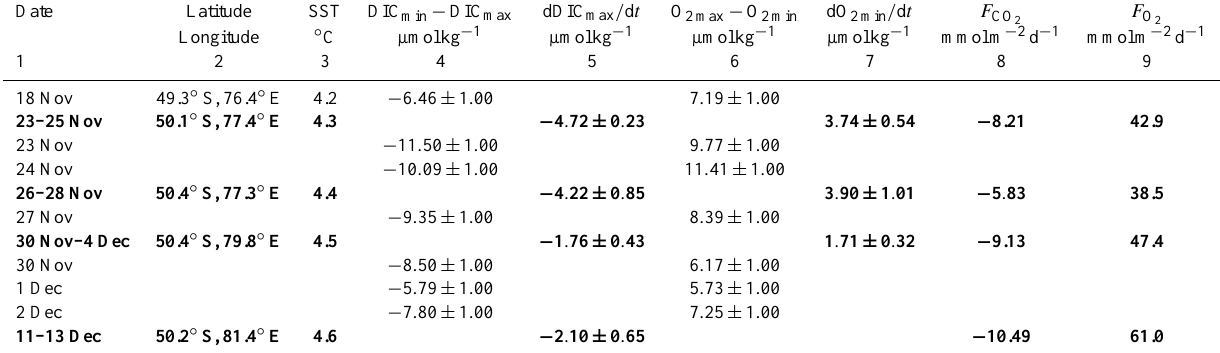
Table 1. Difference between the extrema of DIC and O 2 measured in the warm surface layer (columns 4 and 6). In bold, mean values of DIC and O 2 changes over consecutive mornings (columns 5 and 7), CO 2 and O 2 air–sea flux (columns 8 and 9) are shown.